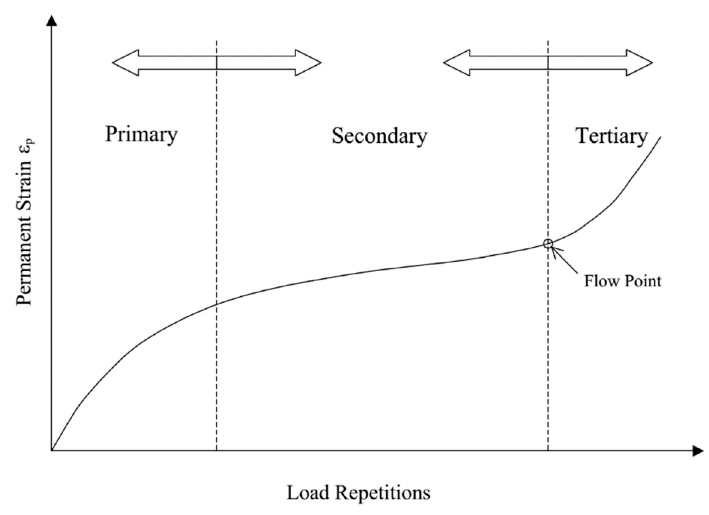
Figure 1. Typical repeated load permanent deformation behavior of pavement materials.